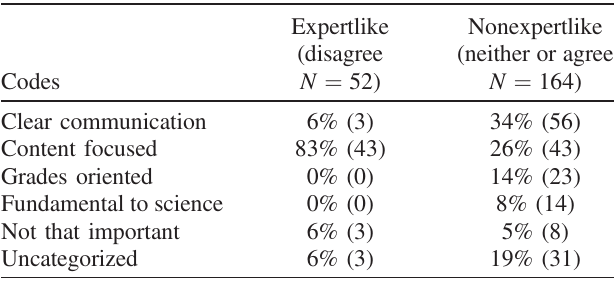
TABLE VI. Student views about Q2a “ When communicating the results from an experiment, my main goal is to have the correct sections and formatting. ” The percent of students with expertlike or nonexpertlike Likert-scale selections whose reason- ing contained particular codes. Students ’ reasoning may be coded under several codes when appropriate so percents in each column may not add up to 100%. N is the total number of students with expertlike or nonexpertlike views and the number of students with each code is given in parentheses. Codes with total frequency less than 10 (around 5% of the total population) are not